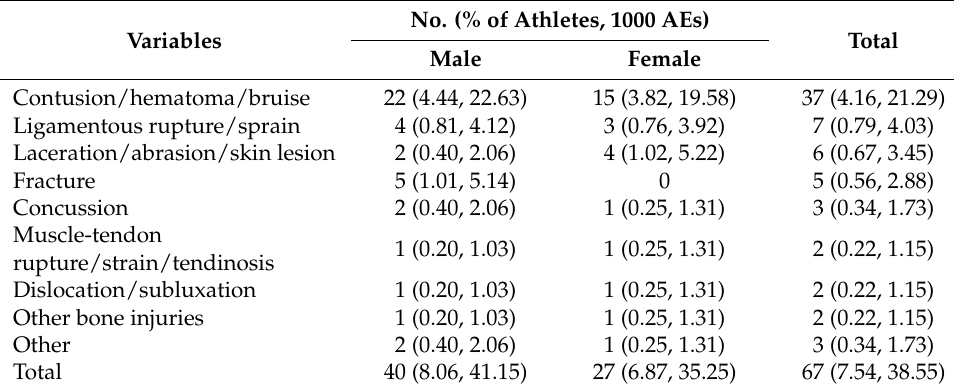
Table 3. Types of injury that occurred at the 2018